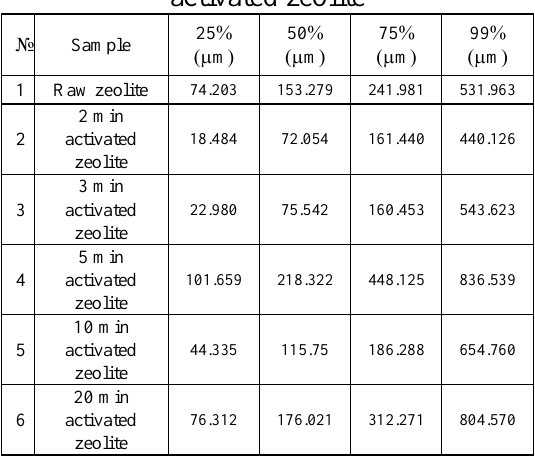
Table 3. Particle size distribution of raw and activated zeolite